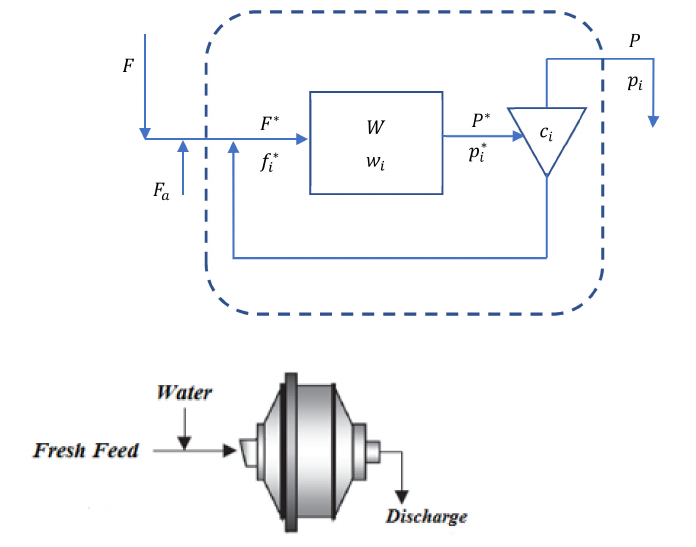
Figure 2. Schematic representation of a SAG mill, adapted from